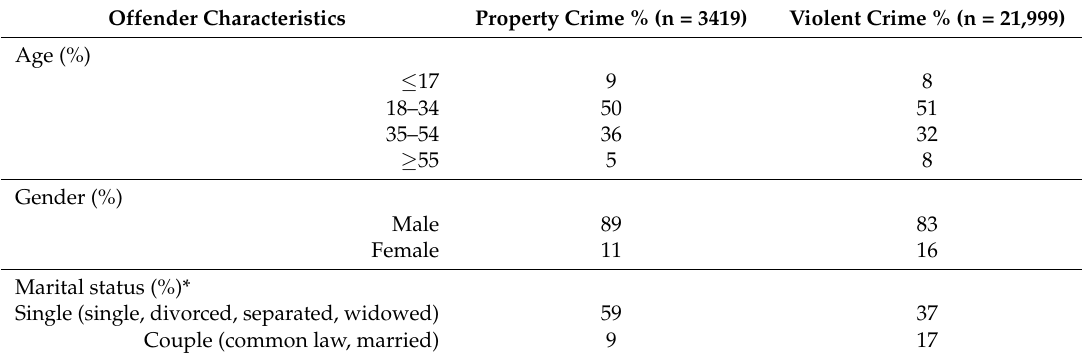
Table 2. Demographic characteristics of property and violent crime offenders,